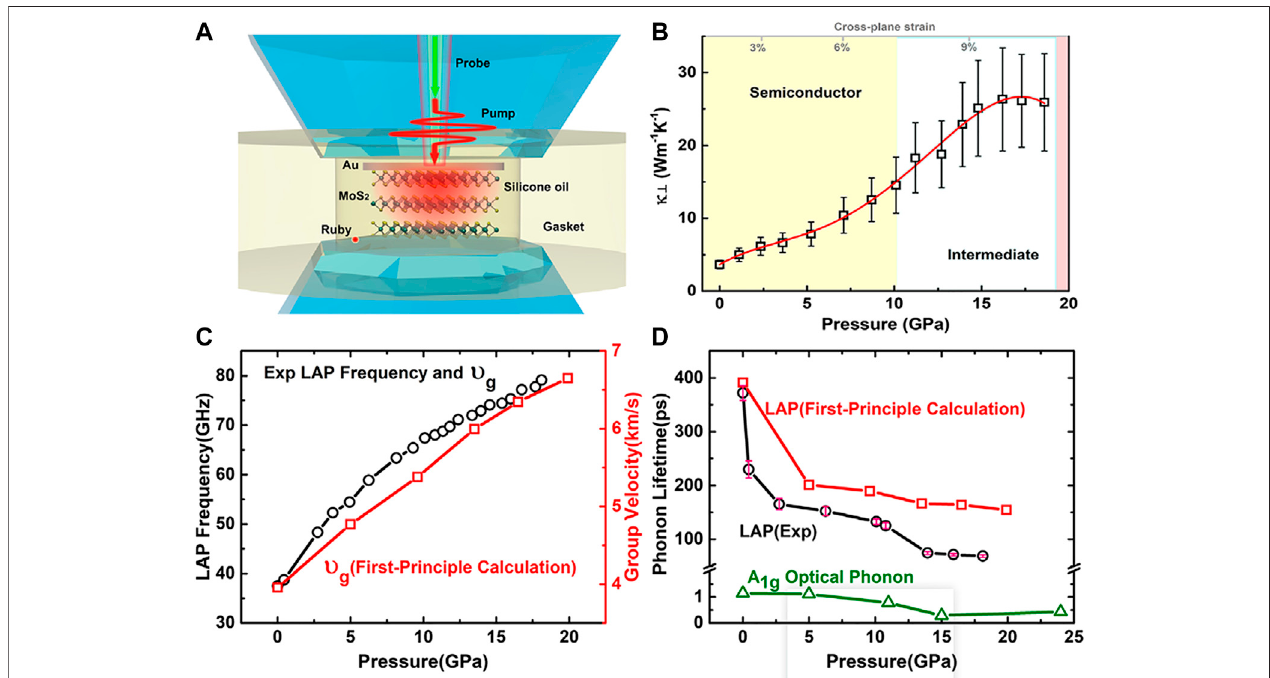
FIGURE 7 | (A) Schematic of thermal conductivity measurement with a diamond anvil cell integrated with a picosecond TRTR, (B) Extracted cross-plane thermal conductivity (dominated by phonons) as a function of pressure. The red curve is included only as a guide to the eye, (C) Pressure-dependent coherent longitudinal acoustic phonons (LAP) frequencies extracted from coherent phonon spectroscopy (CPS) measurements (black circles) and LAP group velocities from fi rst-principles calculations (red squares), (D) Pressure-dependent LAP lifetimes extracted from CPS measurements (black circles) and from fi rst-principles calculations (red squares), as well as lifetimes of A 1g optical phonons extracted from Raman measurements (green triangles). Reproduced from (Meng et al., 2019) with permission from American Physical Society.